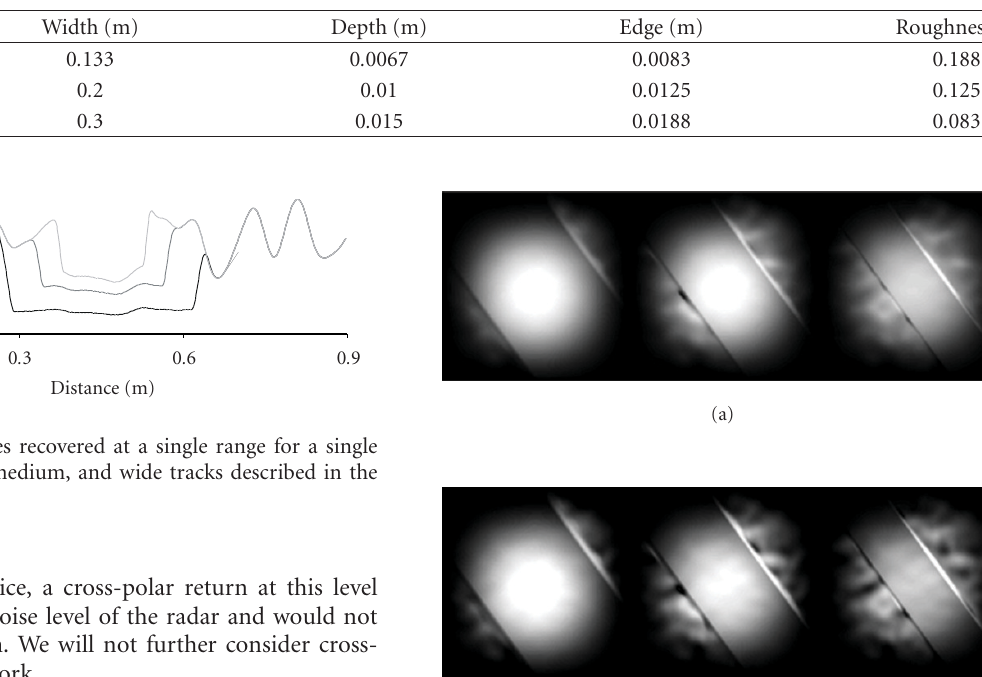
Table 2: Parameters describing the tyre track impressions made in the rough surfaces between simulated SAR observations. The edge distance is the thickness of the region over which the height and roughness return from their suppressed values to the unchanged values.